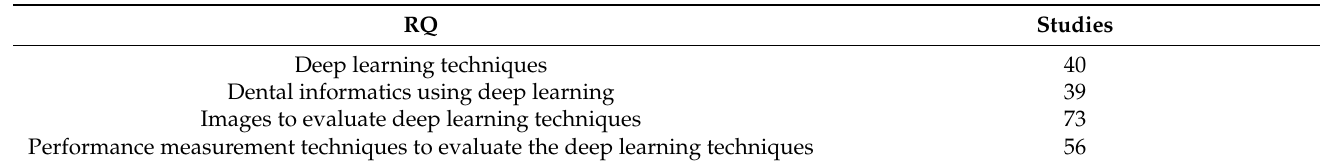
Table 2. RQ Selected